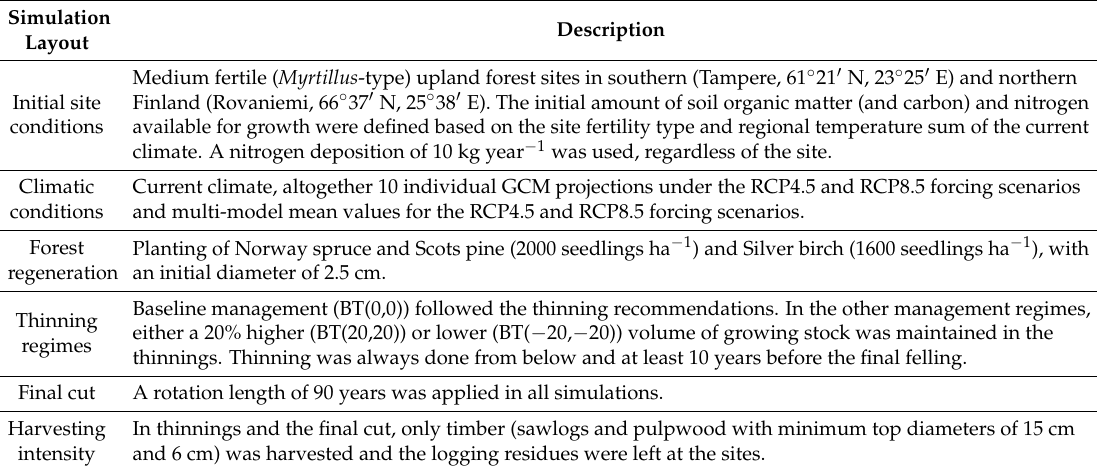
Table 1. Simulation layout with initial site conditions, climates and management